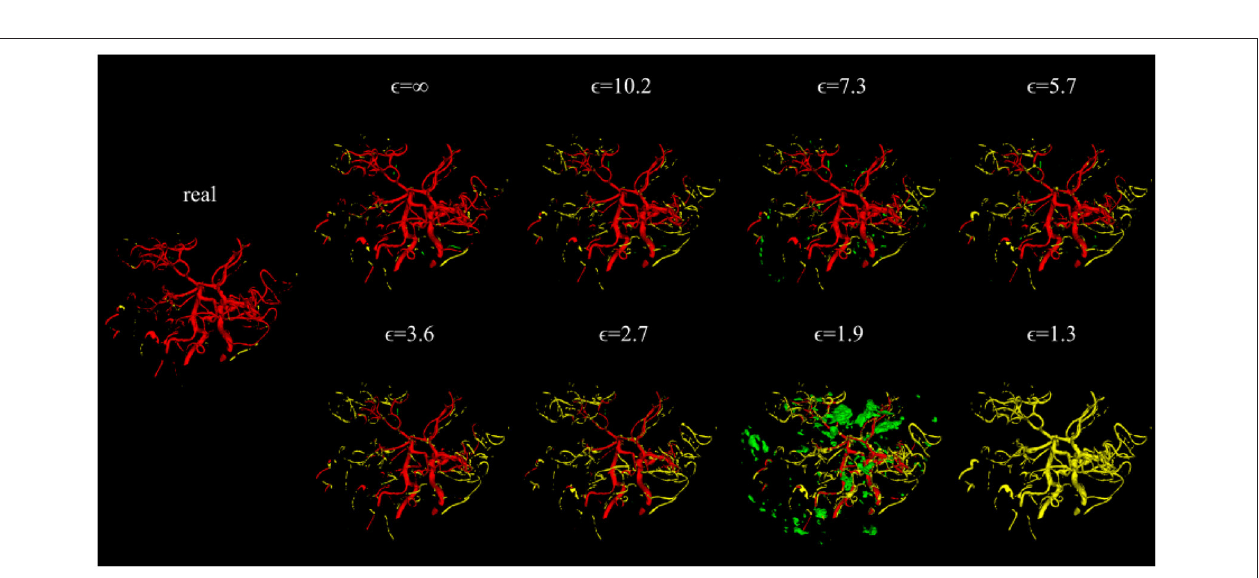
FIGURE 3 | Test segmentation performance of U-Nets trained on generated data with different values of ǫ (PEGASUS dataset). (A) shows a boxplot showing the DSC over 5 runs for each value of ǫ . In (B) , only the run with the best DSC is shown. (C) shows the balanced average Hausdorff distance (bAHD) in voxels for the best run for each ǫ . The errorbar depicts the SD between patients. For ǫ < 5, the performance becomes unstable and worse compared to higher ǫ values.